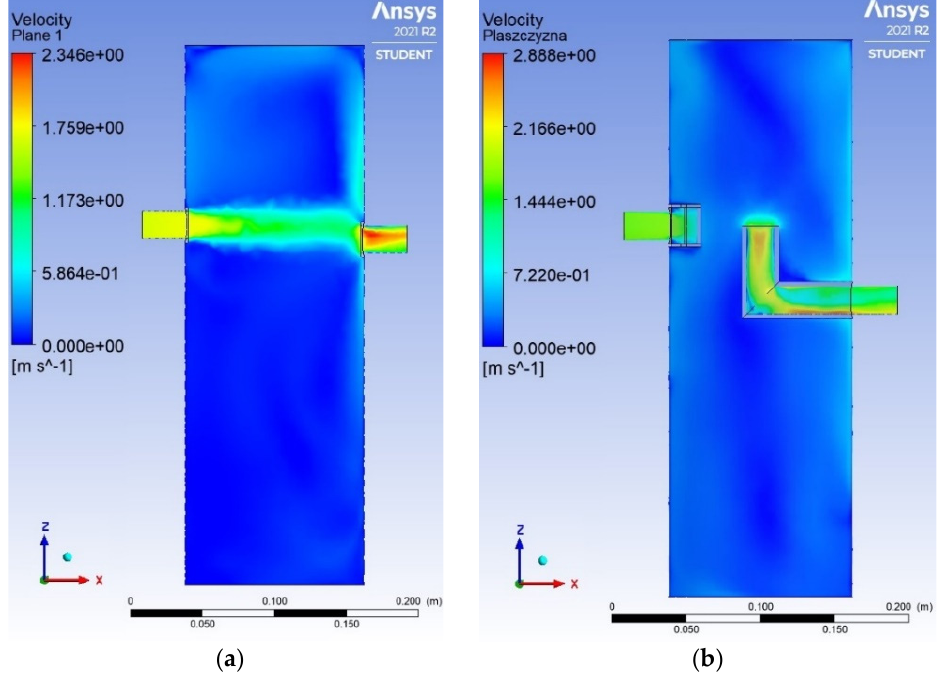
Figure 8. The distribution of the velocity of the fluid particles along the axis in the case of velocity v 5 for: ( a ) OS, ( b ) OW.